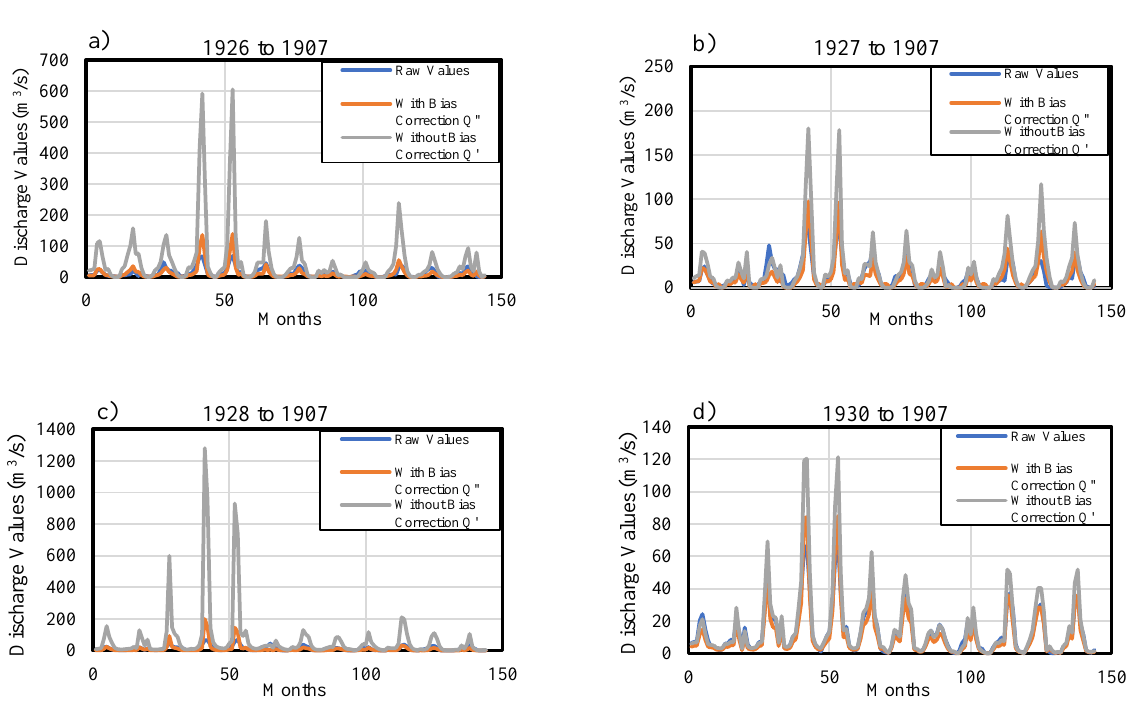
Figure 2. Temporal changes in the streamflow values for the number 1906 SGS. ( a ) 1926 to 1906, ( b )1927 to 1906, ( c ) 1928 to 1906, ( d ) 1930 to 1906.